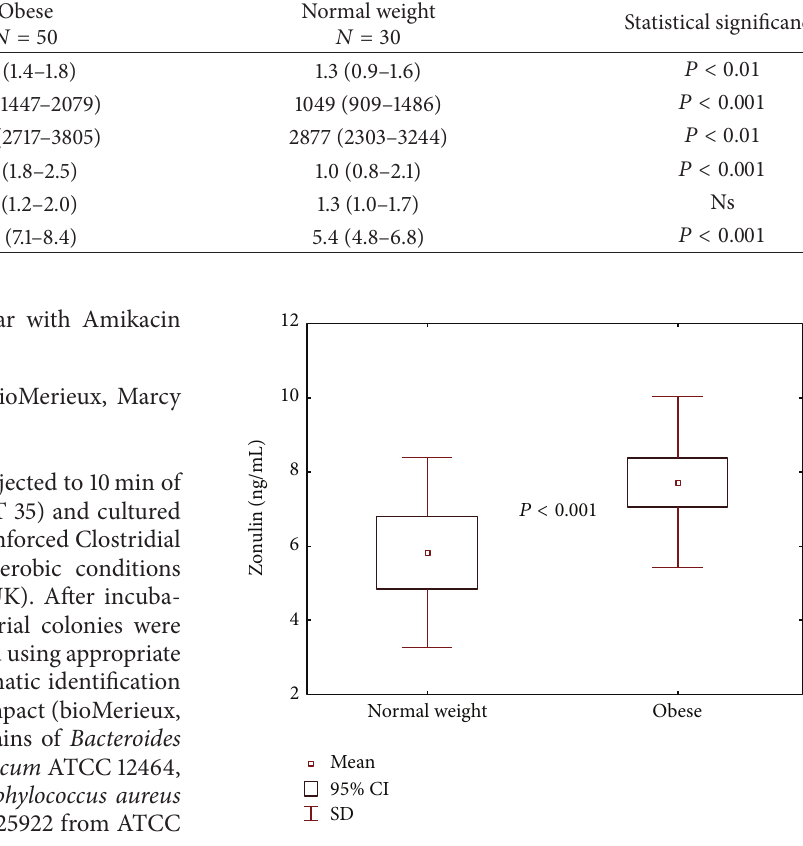
Figure 2: The comparison of mean zonulin concentrations in study